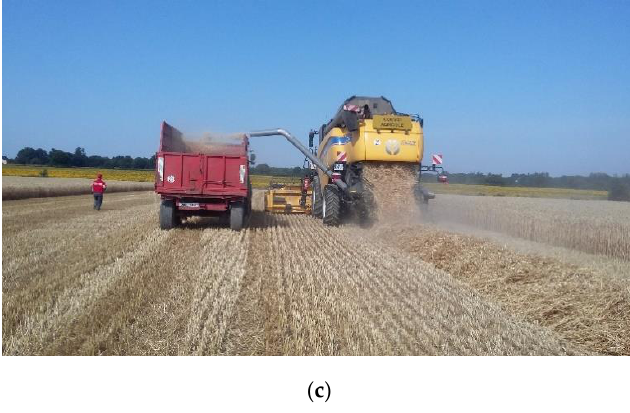
Figure 3. The Thievin system working arrangements—unloading of the chaff on the straw swath ( a ); chaff spreading mode ( b ); and unloading of the chaff on a trailer ( c ).